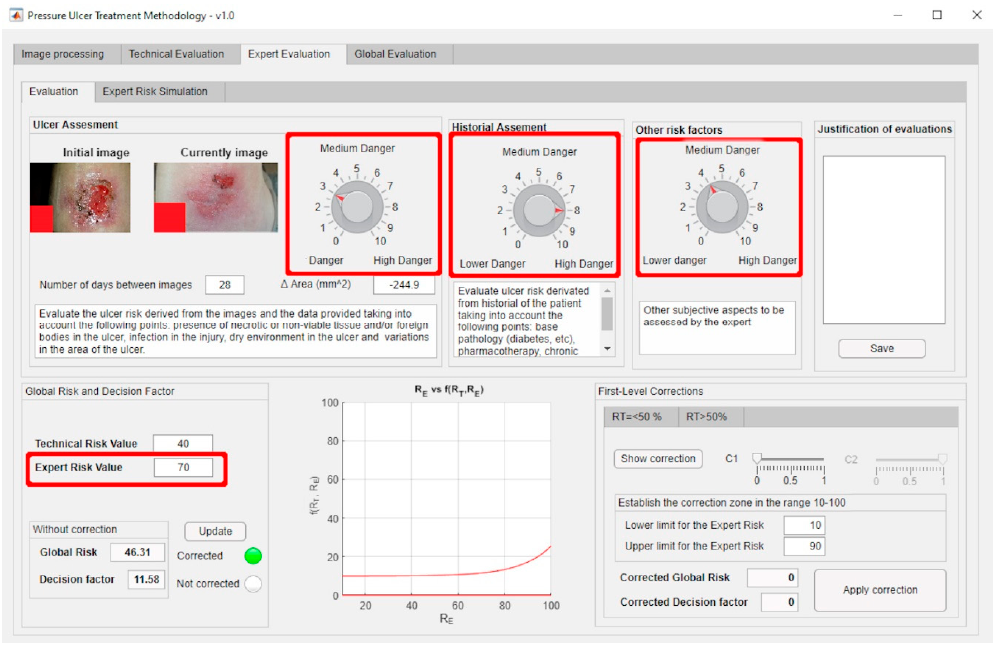
Figure 22. Expert evaluation panel.